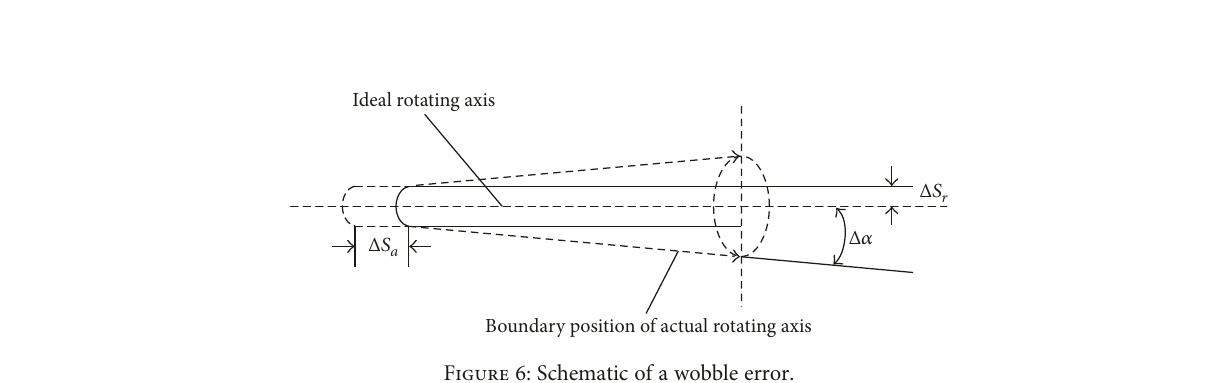
Figure 5: Lines of